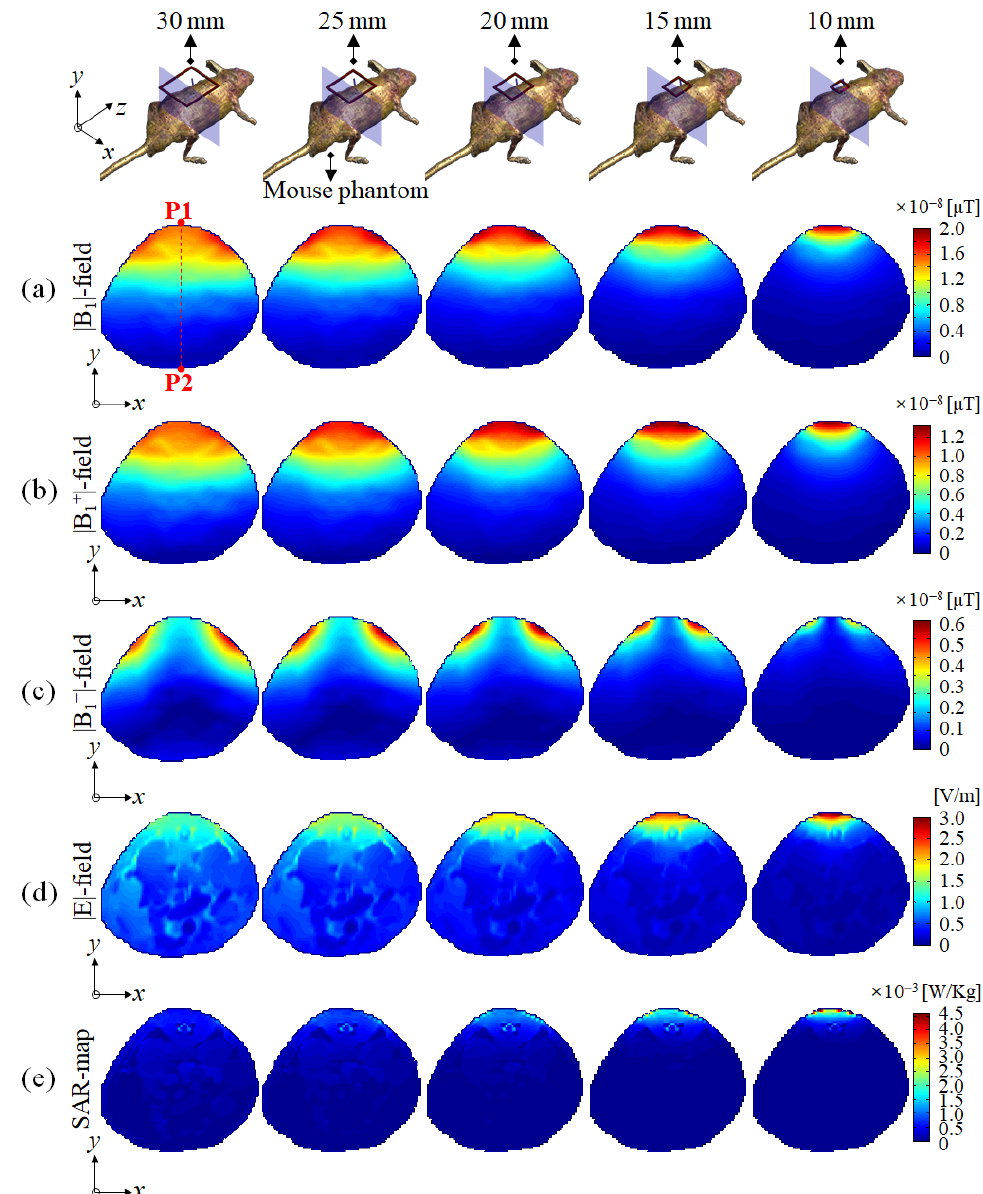
Figure 4. EM-field simulation results using mouse phantom in the axial slice ( x – y plane): ( a ) |B 1 |-